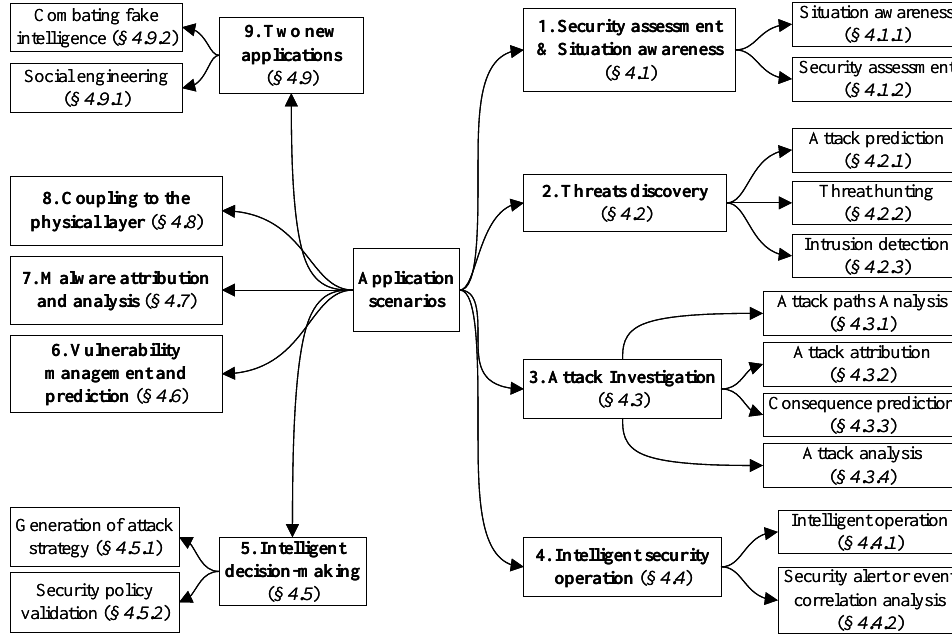
Figure 4. Application scenarios of cybersecurity knowledge